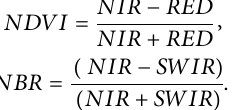
Frontiers in Environmental Science |